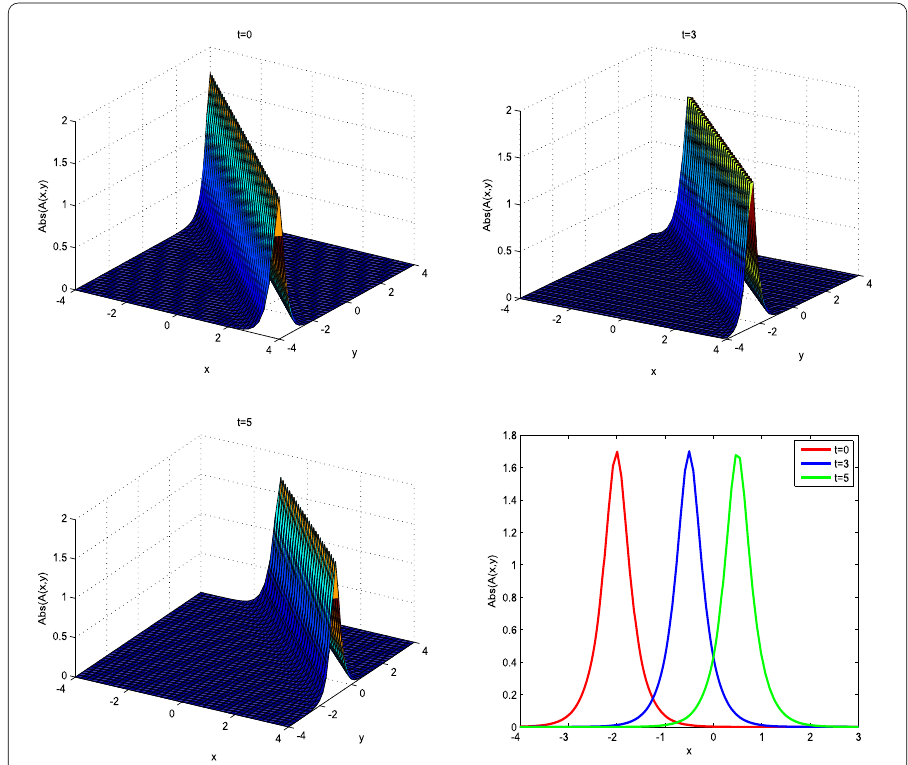
Figure 1 The soliton solution and the solitary wave profiles for various timescales for T = 0, T = 3, and T = 5,